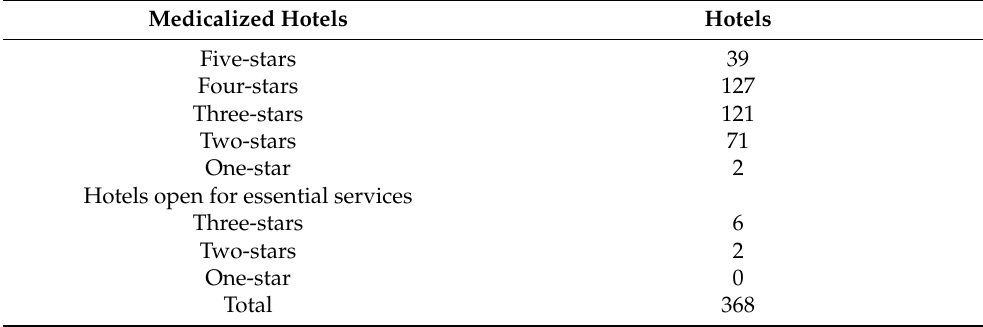
Table 3. Medicalized hotels and hotels open for essential services distributed according to the hotel touristic